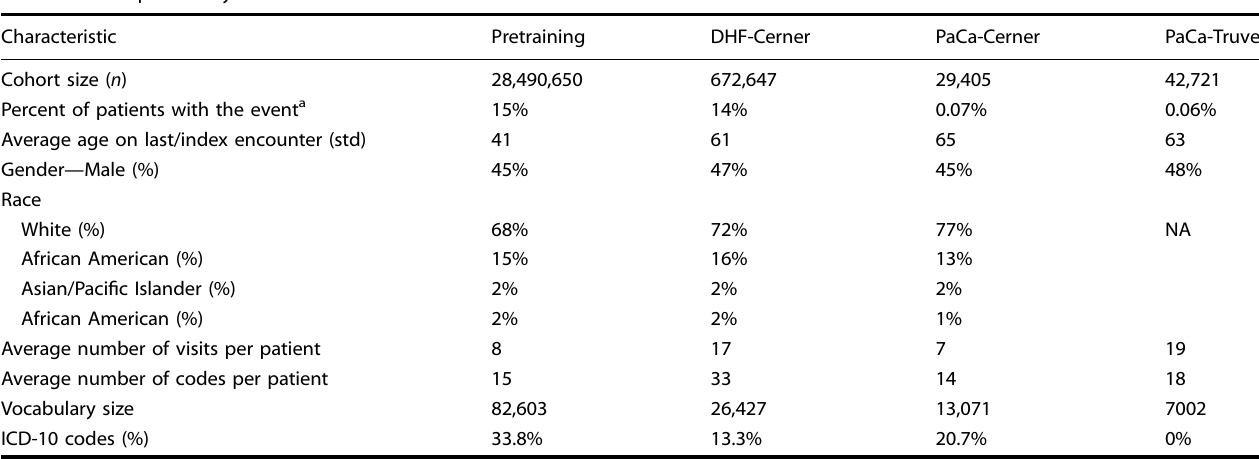
Fig. 1 Selection pipeline for the pretraining cohort from Cerner HealthFacts. The fl ow starts from left to right. Number of patients is between square brackets. Table 2. Descriptive analysis of the